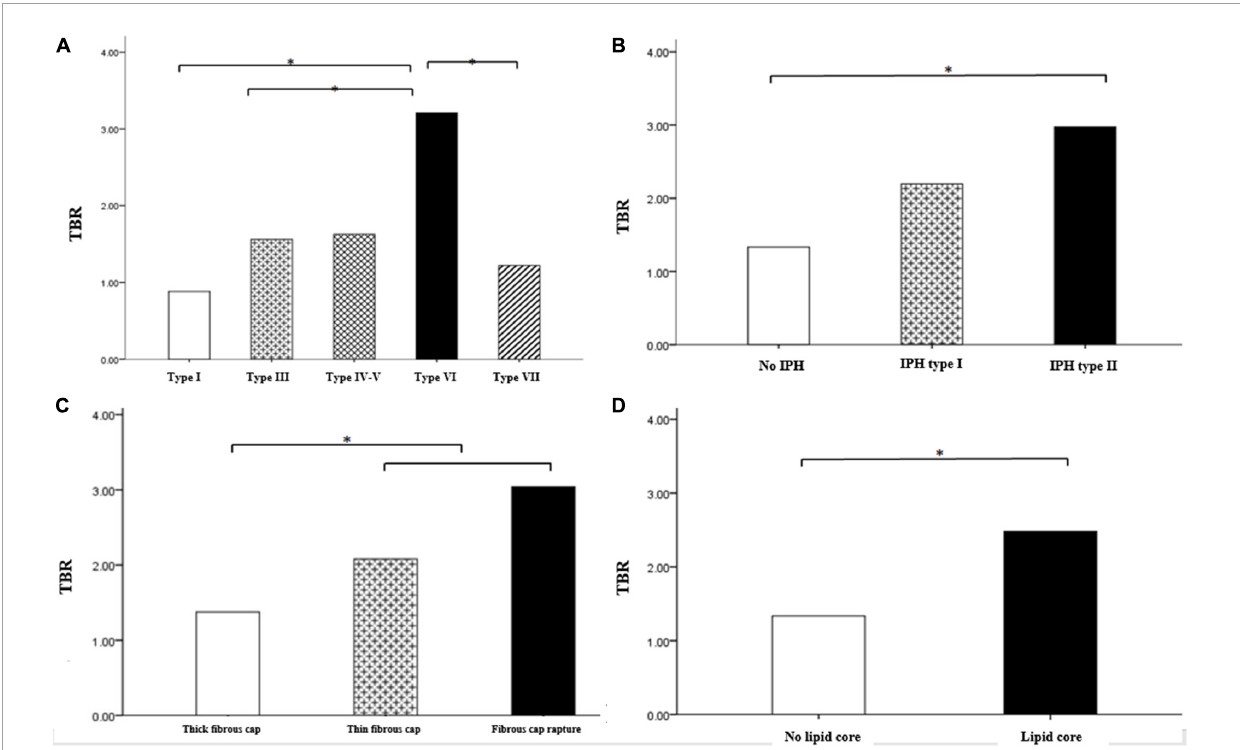
FIGURE4 Comparison of TBR between carotid plaques of different MRI types. Comparison of TBR value of carotid plaques with different AHA classification (A) Comparison of TBR values of intra plaque hemorrhage (B) fiber cap state (C) , and lipid necrosis core (D) . Among the different types of carotid atherosclerotic plaques in the modified MRI classification, TBR values were higher in AHA type VI including intra-plaque hemorrhage, fibrous cap rupture and thin, also and lipid core. * P < 0.05.